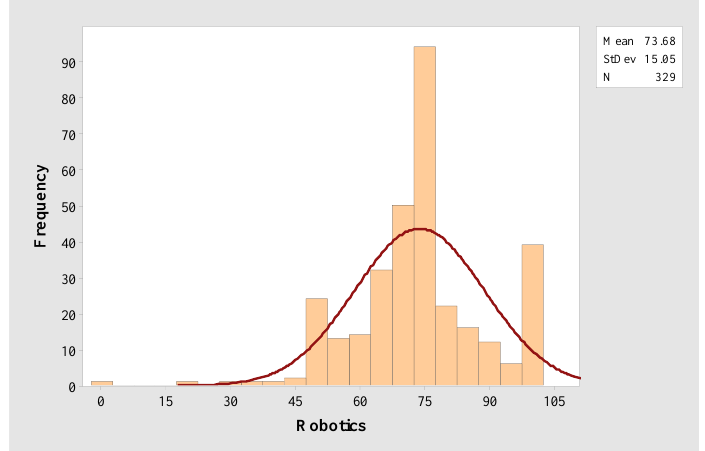
Source : Sample Survey, 2022